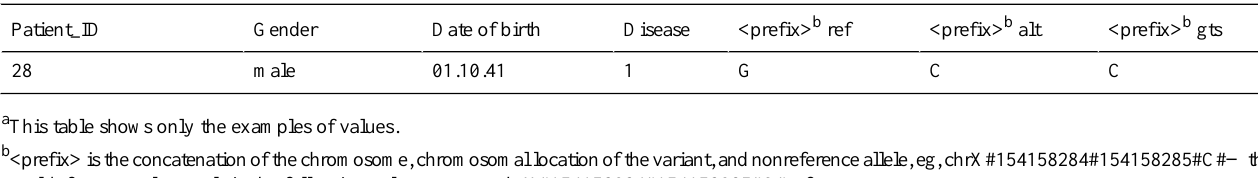
Table 3. Example of a prepared data set. a